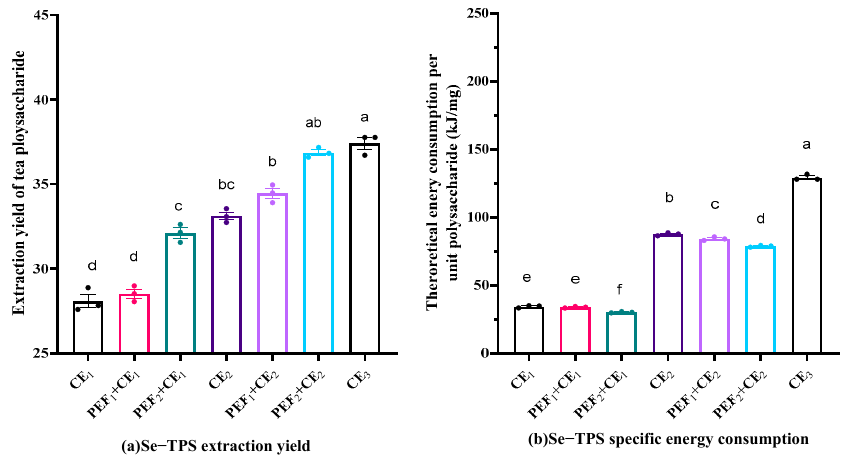
Figure 2. Se − TPS extraction yield ( a ) and specific energy consumption ( b ) in CE and PE + CE processes. Different letters above the columns represent extraction yield and energy consumption differ significantly ( p < 0.05).